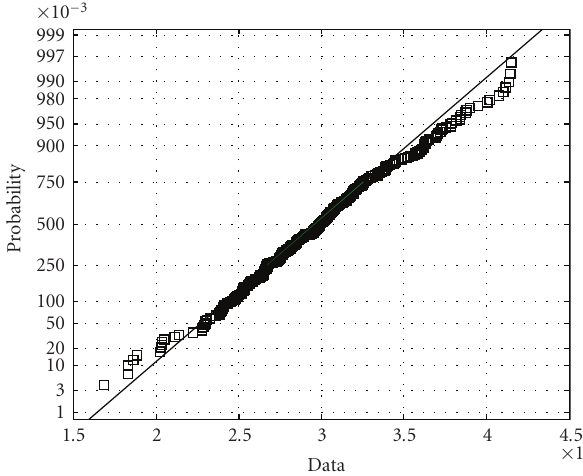
Figure 3: Normal Probability Plot, Comparing Normal PDF with the PDF of the Ideal Burst size.